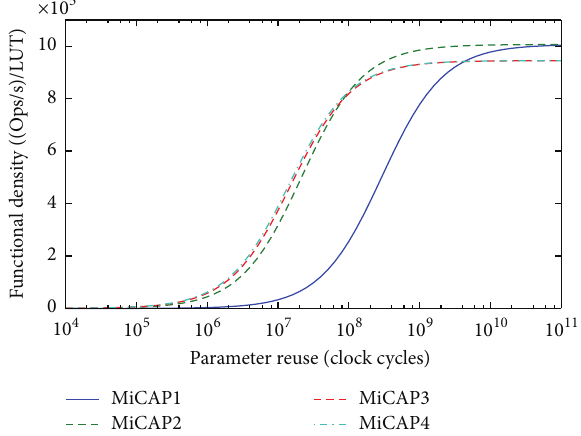
Figure 10: Functional density curves for MiCAP with different reconfiguration drivers.